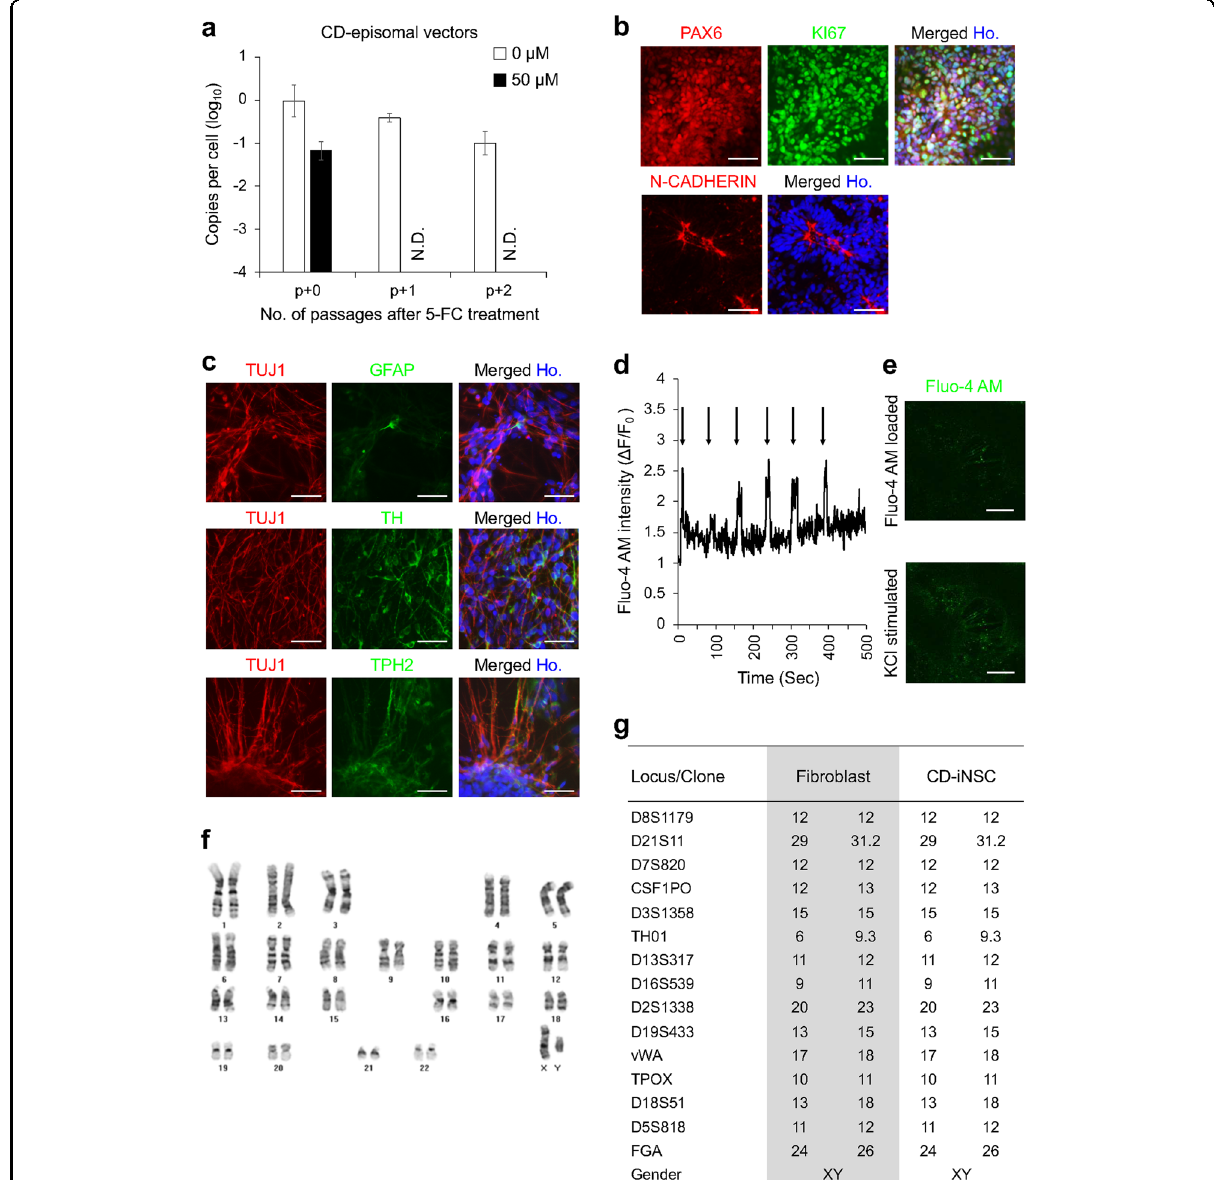
Fig. 5 Rapid elimination of residual CD episomal vectors in human-induced neural stem cells. a qPCR analysis of total DNA in CD-iNSCs cultured with or without 5-FC was used to measure the copy numbers of residual CD episomal vectors. N.D. indicates not detected. b Immunocytochemistry of NSC markers that were expressed in the isolated EF-iNSCs. Scale bars represent 100 µm. c Images of immunocytochemical staining of neuronal and glial markers are shown to con fi rm the differentiation potential of isolated EF-iNSCs. d KCl-induced transient Ca 2 + (real-time) in neurons at eight weeks post differentiation. The arrow represents KCl stimulation. e Representative images of Fluo-4 AM- loaded neurons pre and post KCl administration. Scale bars represent 200 µm. f G-banding analysis of EF-iNSCs showed normal human karyotypes. g STR analysis revealed that the CD-iNSCs were derived from the original CRL2097 fi